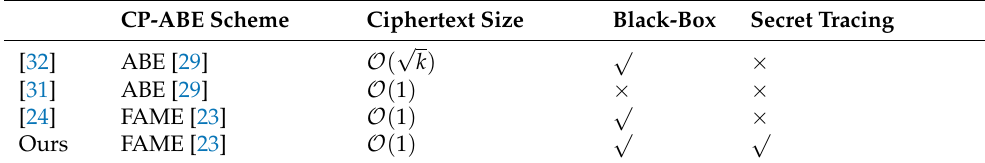
Table 1. Comparison of traceable CP-ABE schemes.